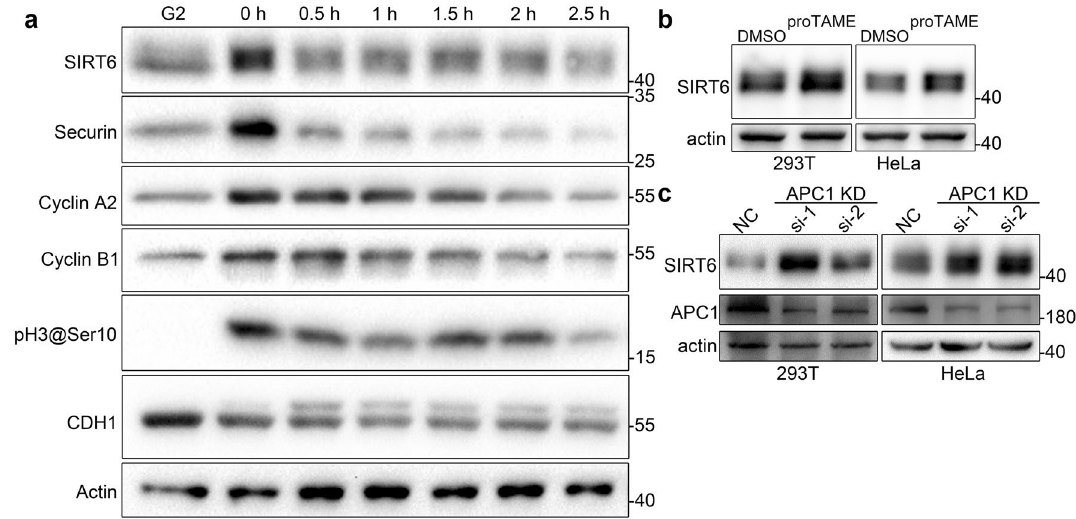
Figure 3. APC/C leads to SIRT6 decrease. ( a ) HeLa cells were synchronized to the G2 phase and samples were collected with the procedure shown in Supplementary Fig. S4. G2 samples were collected without release from RO-3306 and other cells were released. The time when most cells entered mitosis was designated as 0 h when mitotic cells were physically detached, and detached cells were cultured separately and sampled at 0.5 h intervals from 0 to 2.5 h. Changes in the indicated proteins were detected by immunoblotting. Actin was used as a loading control. ( b ) 293 T and HeLa cells were treated with 10 μM proTAME or DMSO for 12 h. SIRT6 levels were examined by immunoblotting. Actin was used as a loading control. ( c ) 293 T and HeLa cells were transfected with non-specific control (NC) or APC1 knockdown siRNAs. SIRT6 levels were examined